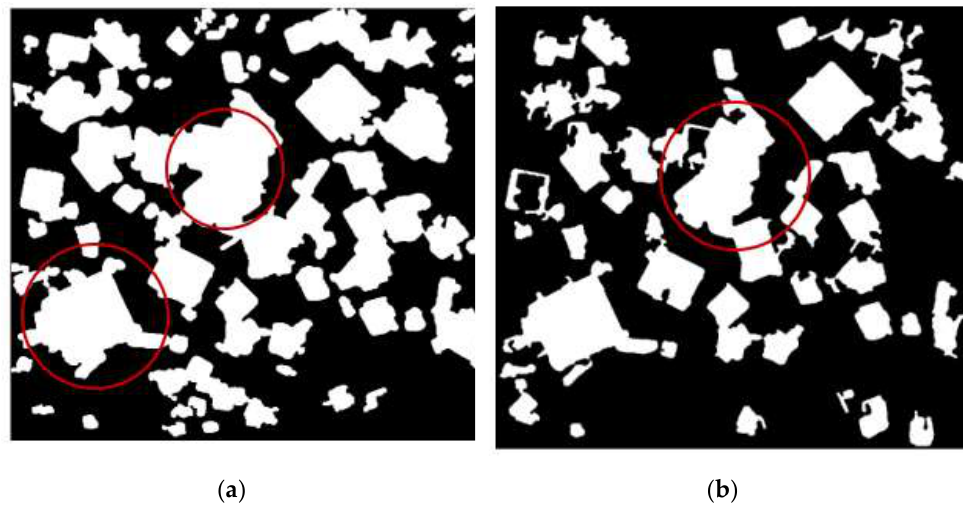
Figure 7. Visual comparison of the crystal image with different methods: ( a ) multi-Canny segmentation; ( b ) threshold segmentation.